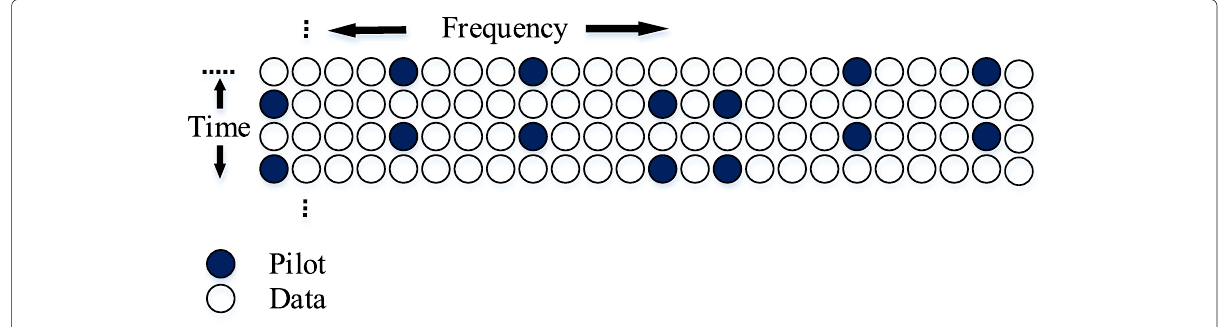
Fig. 3 Pilot distribution in WiMAX, DL-PUSC configuration [29]